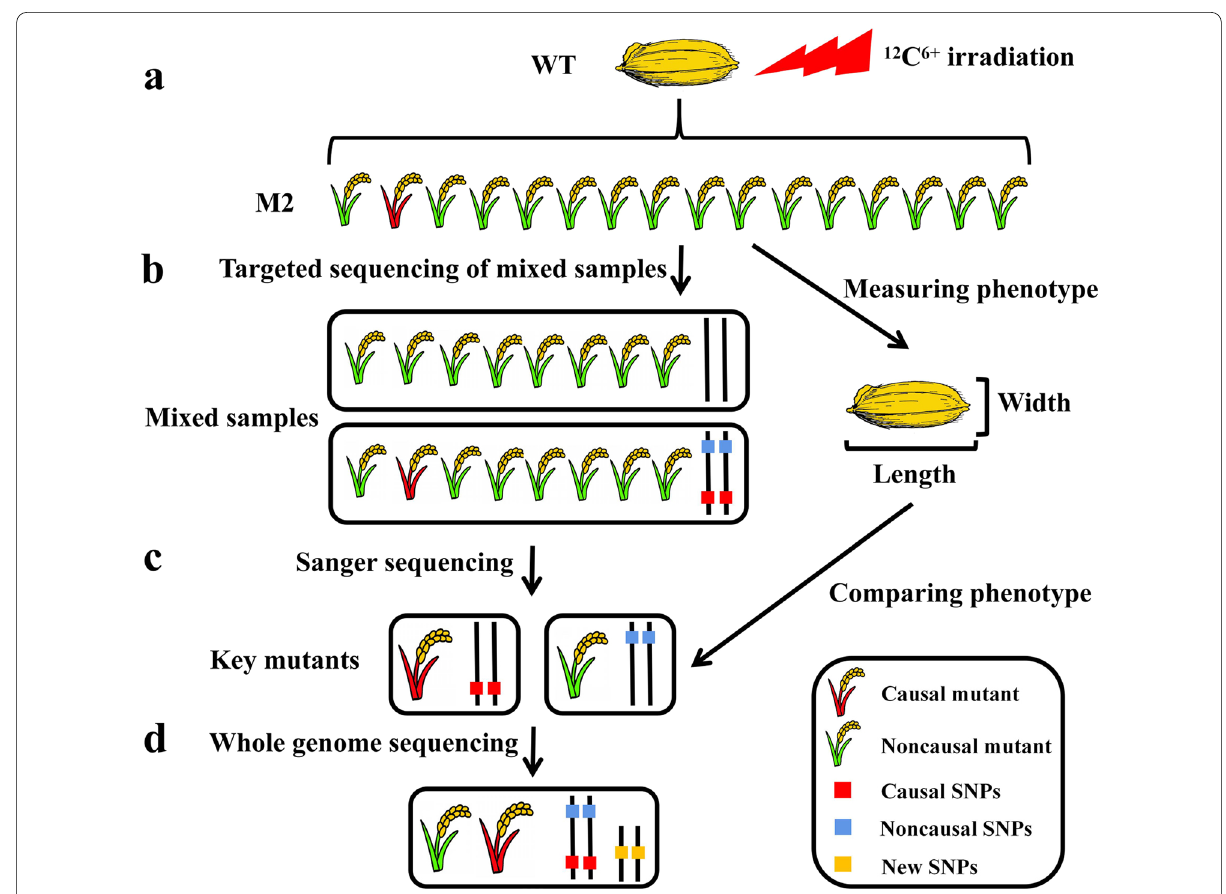
Fig. 1 Simplified steps of the MTWA process. a Wild-type (WT) seeds were irradiated with a carbon ion beam, and the M 2 generation was planted and harvested. b The M 2 generation mixed samples were constructed at a ratio of 8:1 for targeted sequencing detection, and the grain shape of the M 2 generation seeds was measured. c Sanger sequencing was performed on individual plants in a mixed sample of potential mutations detected by targeted sequencing and compared with phenotypes to identify key mutants. d WGS of key mutants to resolve associations between mutant phenotypes and genotypes and to mine for novel allelic